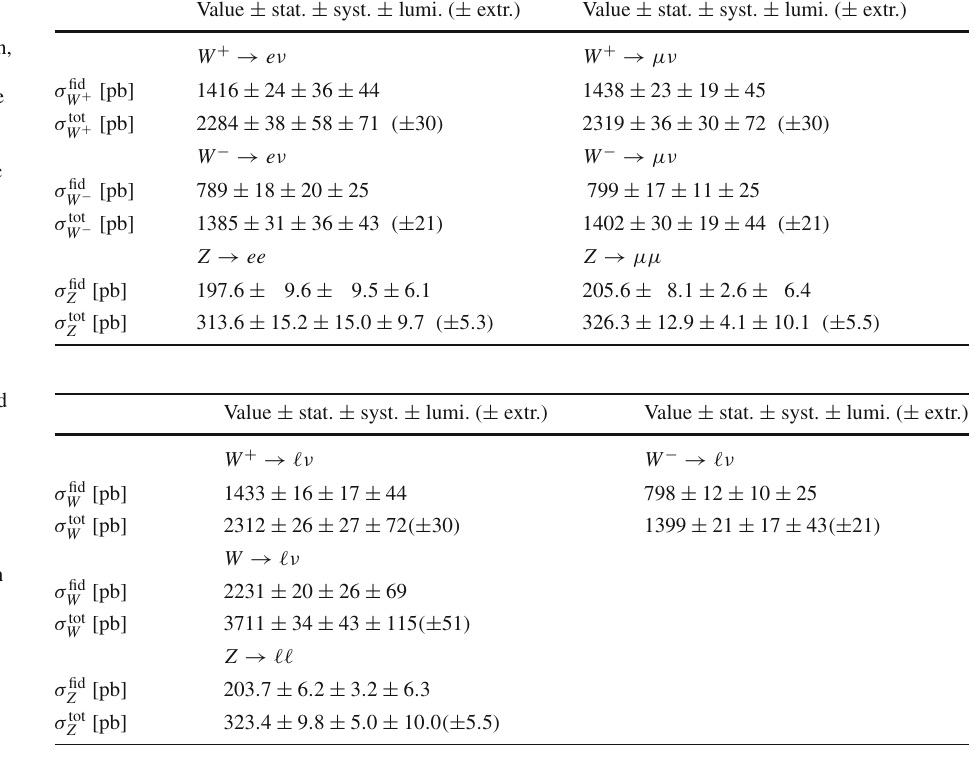
Table 6 Results of the fiducial and total cross-sections measurements of the W + -boson,